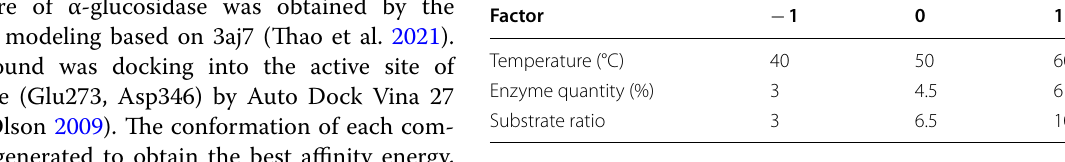
Table 1 Factors and levels of Box–Behnken experiments